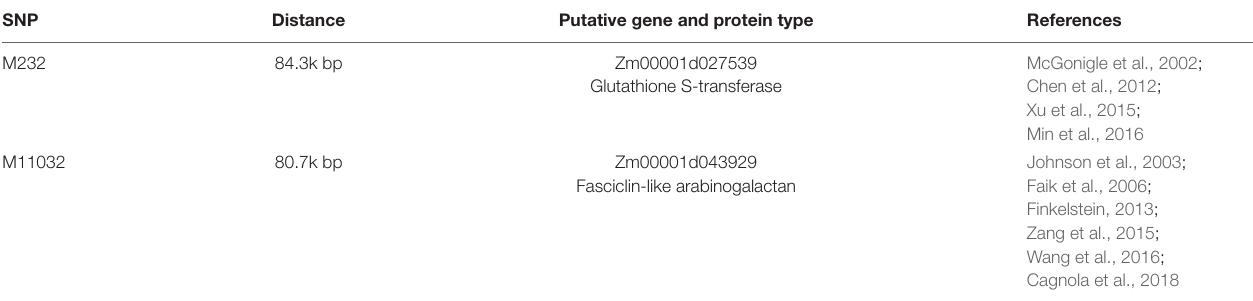
TABLE 8 | Two significative SNPs located close to putative genes that encode proteins associated with plant response to drought. SNP Distance Putative gene and protein